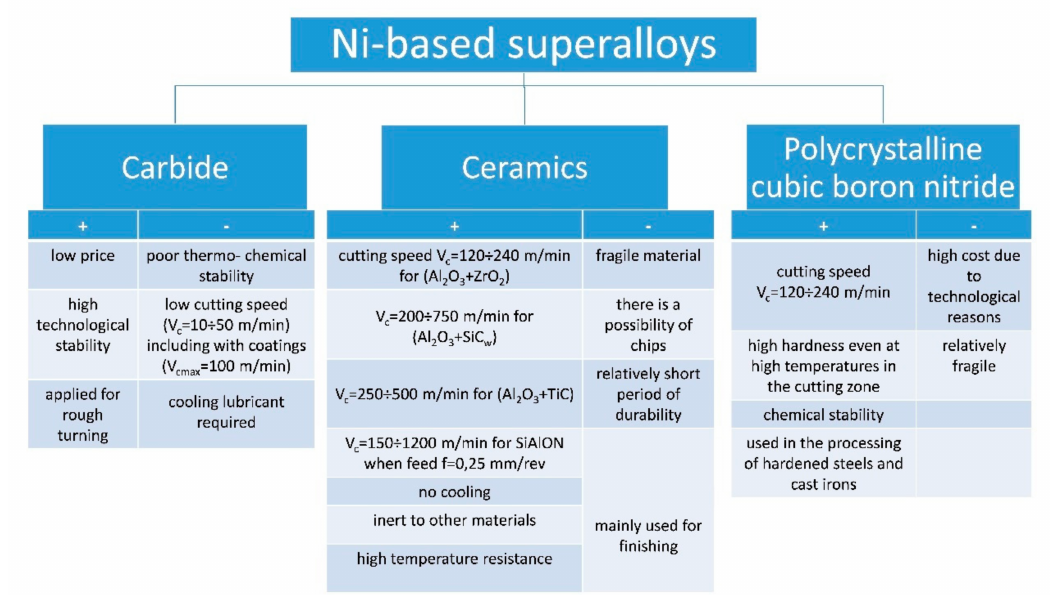
Figure 1. Material categories in the machining of Ni-based